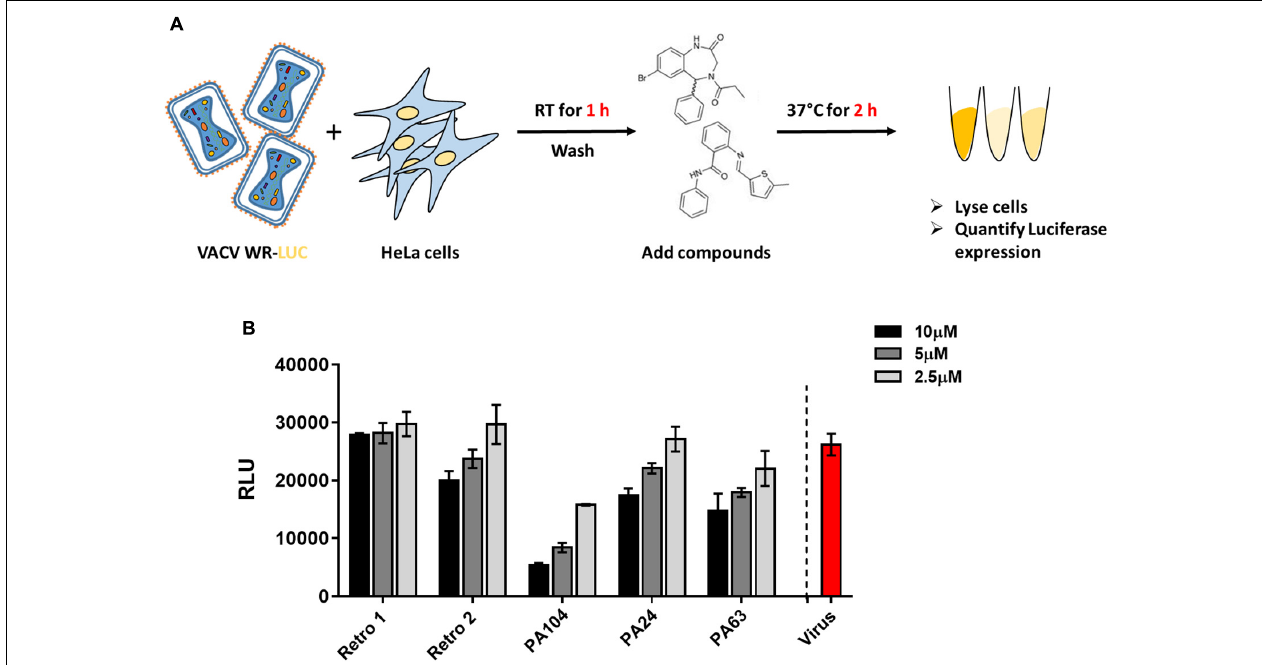
FIGURE 2 | Effect of Retro-1 analogs on early stages of VACV infection. (A) Schematic representation of VACV entry assay. (B) Relative light units (RLUs) in the presence of select retrograde inhibitors diluted to 2.5 µ M (light gray), 5 µ M (dark gray), and 10 µ M (black). Values plotted represent the average of two independent experiments.